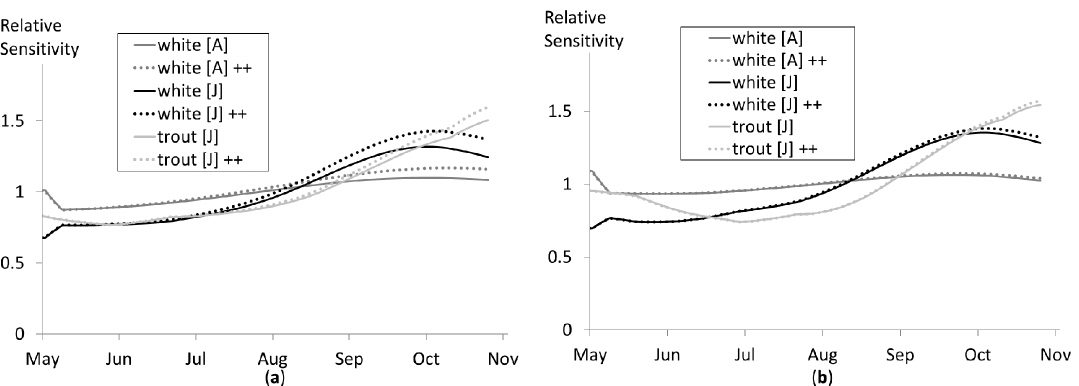
Figure 17. Results of the global sensitivity analysis when increasing (++) or decreasing (--) the initial biomass concentration of Cladocera when ( a ) Chaoborus is not modeled in the ecosystem [12] and when ( b ) Chaoborus is added (extended ecosystem model presented in this paper).